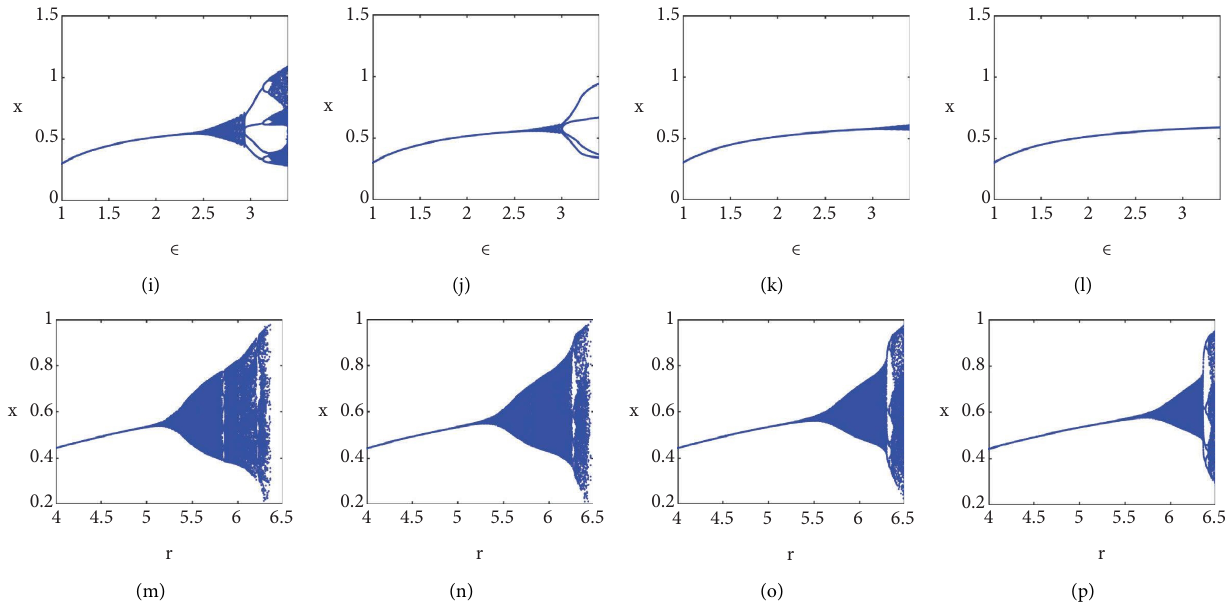
Figure 15: Bifurcation diagrams of model (5) with diferent values of u . Te parameter values for ( a ) − ( d ) corresponding to case (1). Te parameter values for ( e ) − ( h ) corresponding to case (2). Te parameter values for ( i ) − ( l ) corresponding to case (3). Te parameter values for ( m ) − ( p ) corresponding to case (4). (a) u � 0.02, (b) u � 0.05, (c) u � 0.08, (d) u � 0.011, (e) u � 0.02, (f) u � 0.05, (g) u � 0.08, (h) u � 0.011, (i) u � 0.02, (j) u � 0.05, (k) u � 0.08, (l) u � 0.011, (m) u � 0.02, (n) u � 0.05, (o) u � 0.08, and (p) u �